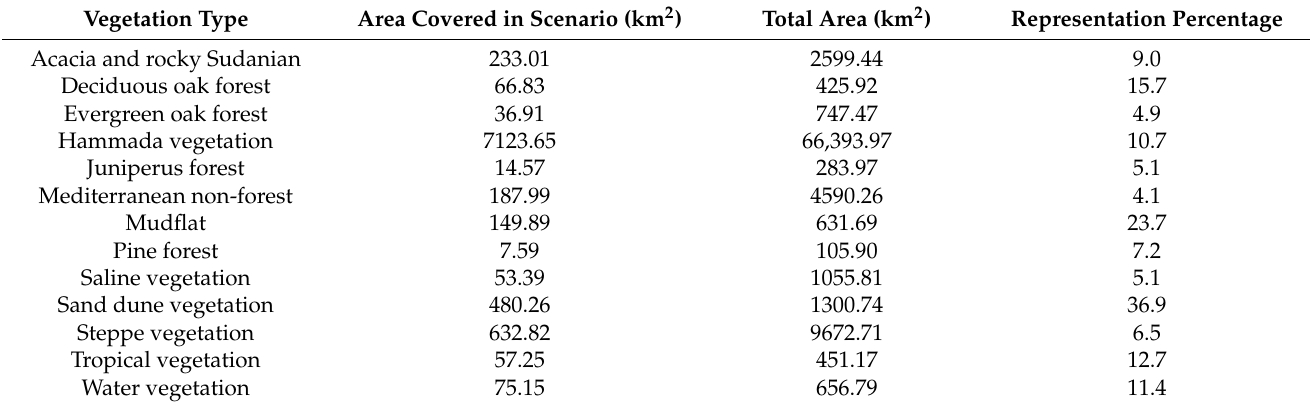
Table 6. The area and representation percentage of each vegetation type in solution for scenario 1.